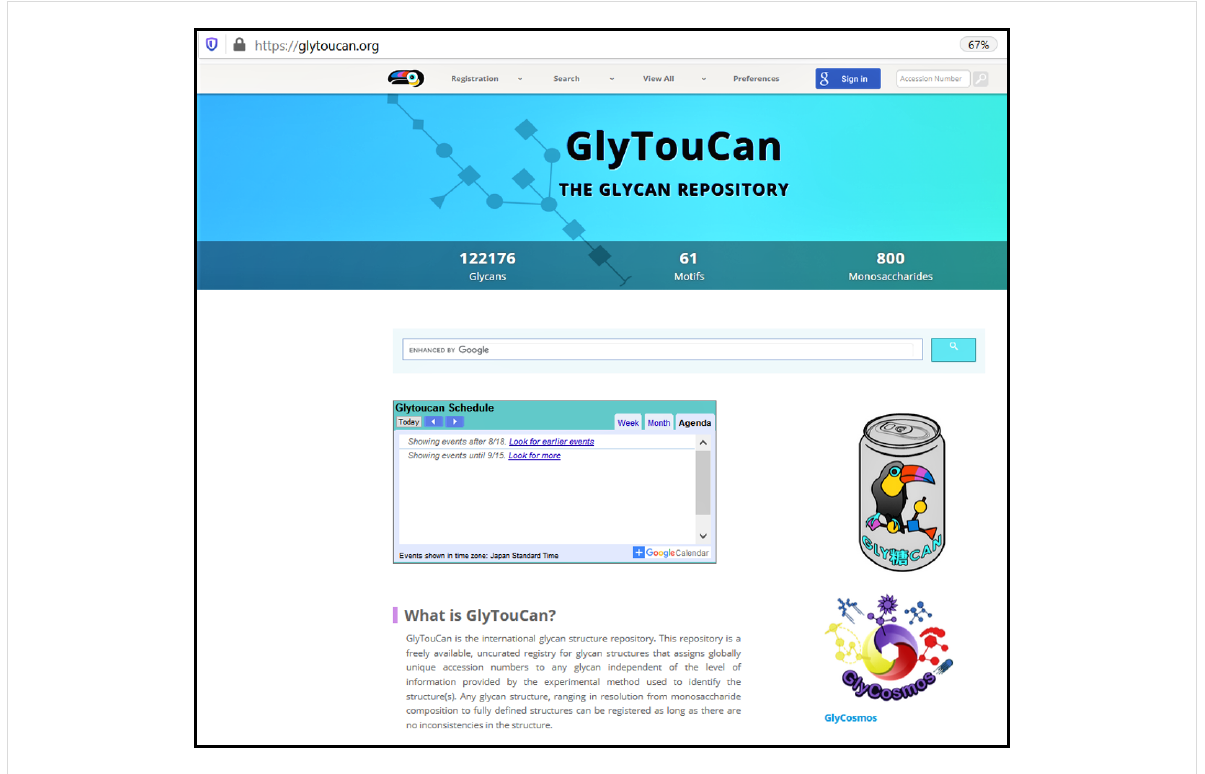
Figure 5: GlyTouCan [38] interface allows to search for glycans structures in the database. Data contained in GlyCosmos portal (https:// glycosmos.org/) and in GlyTouCan repository home page (https://glytoucan.org/), including their logos, are licensed under a Creative Commons Attri- bution 4.0 International License